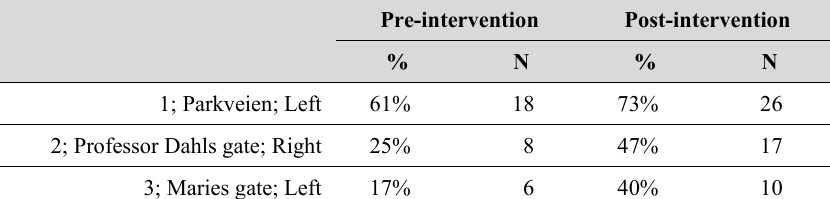
Table 1 Share of participants following the intended route, pre- and post-intervention Pre-intervention Post-intervention % N